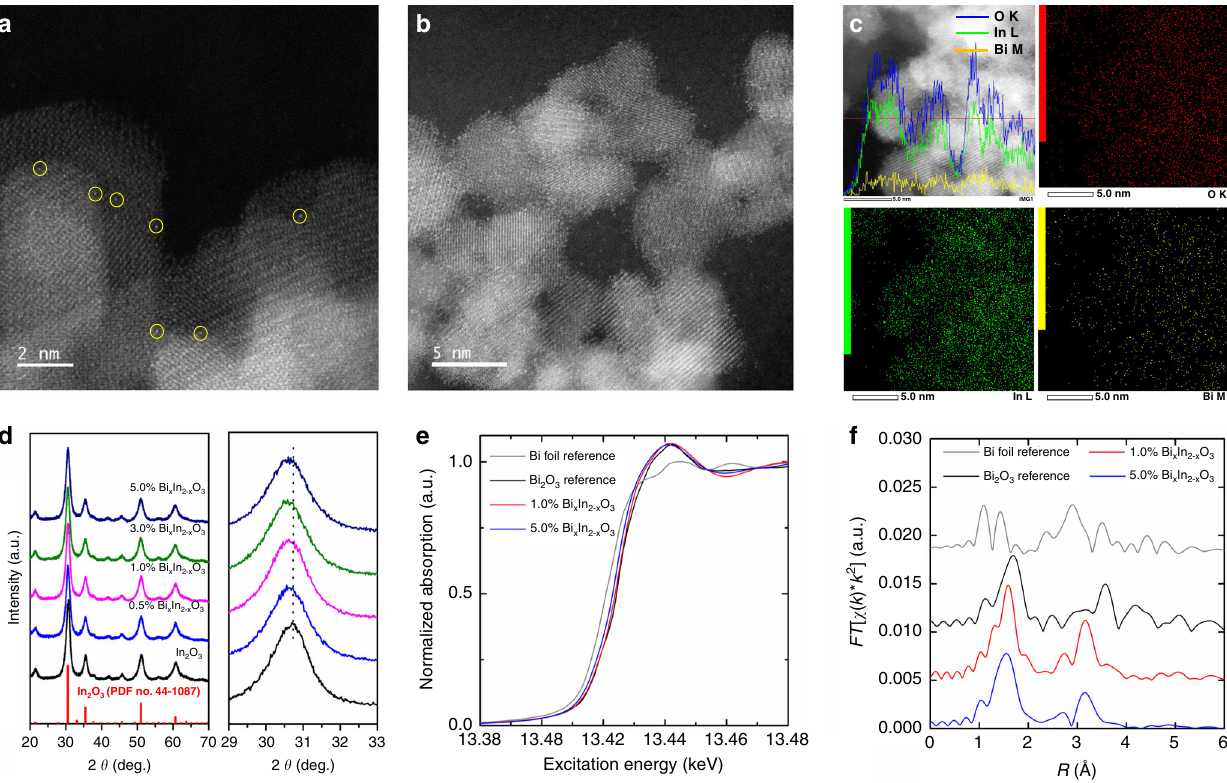
Fig. 1 Structural characterizations of single-site Bi 3 + substituted Bi x In 2 – x O 3 . a Aberration-corrected STEM image of 1.0% Bi x In 2 – x O 3 nanocrystals. b Aberration-corrected STEM image of 5.0% Bi x In 2 – x O 3 nanocrystals. c EDS mapping pro fi les of 5.0% Bi x In 2 – x O 3 along the indicated red line. d PXRD patterns of Bi x In 2 – x O 3 nanocrystals and pristine In 2 O 3 . e Normalized Bi L 3 -edge XANES spectra of 1.0% and 5.0% Bi x In 2 – x O 3 , as well as Bi foil and Bi 2 O 3 references. f k 3 -Weighted Bi L 3 -edge Fourier-transform EXAFS spectra of 1.0% and 5.0% Bi x In 2 – x O 3, as well as Bi foil and Bi 2 O 3